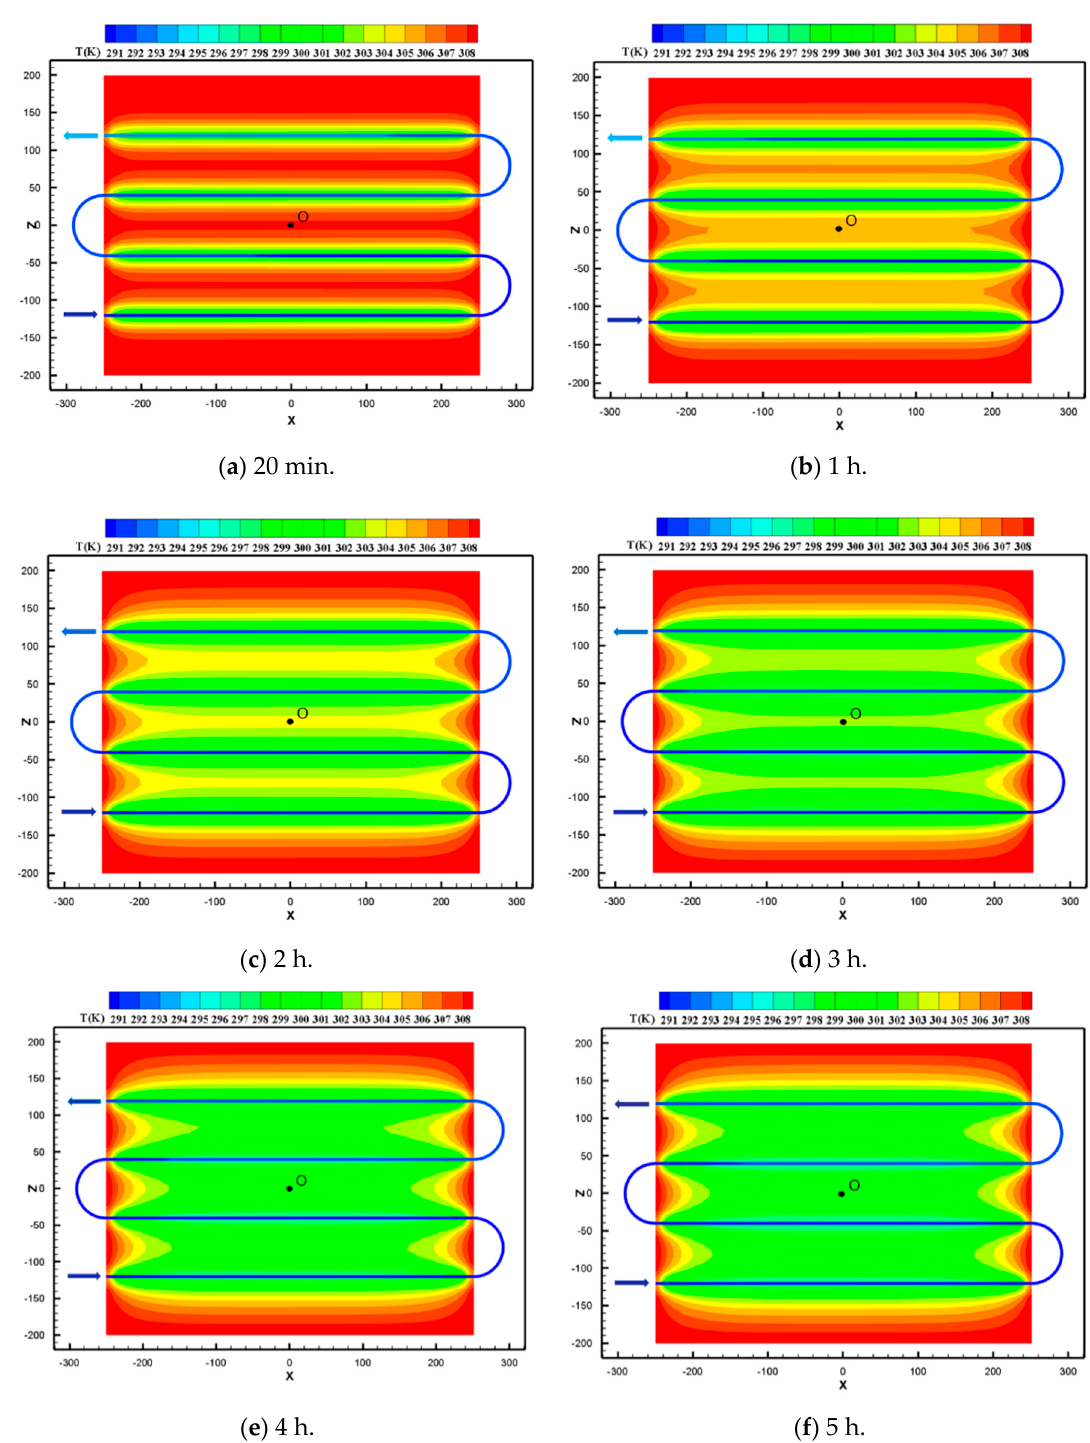
Figure 11. The temperature distribution of the backfill body during the heat release process.